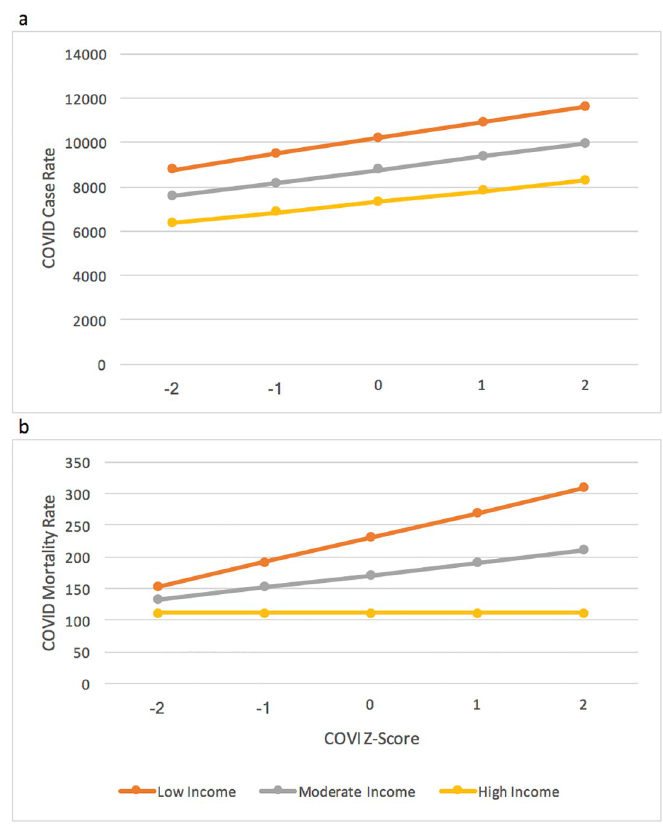
Fig 2. The relationship between Cost of Voting Index (COVI) z-score and COVID-19 outcomes across US county median income (n = 3,106 counties). a. The adjusted relationship between Cost of Voting Index score and county COVID case rate by county median income. b. The adjusted relationship between COVI score and county COVID mortality rate by county median